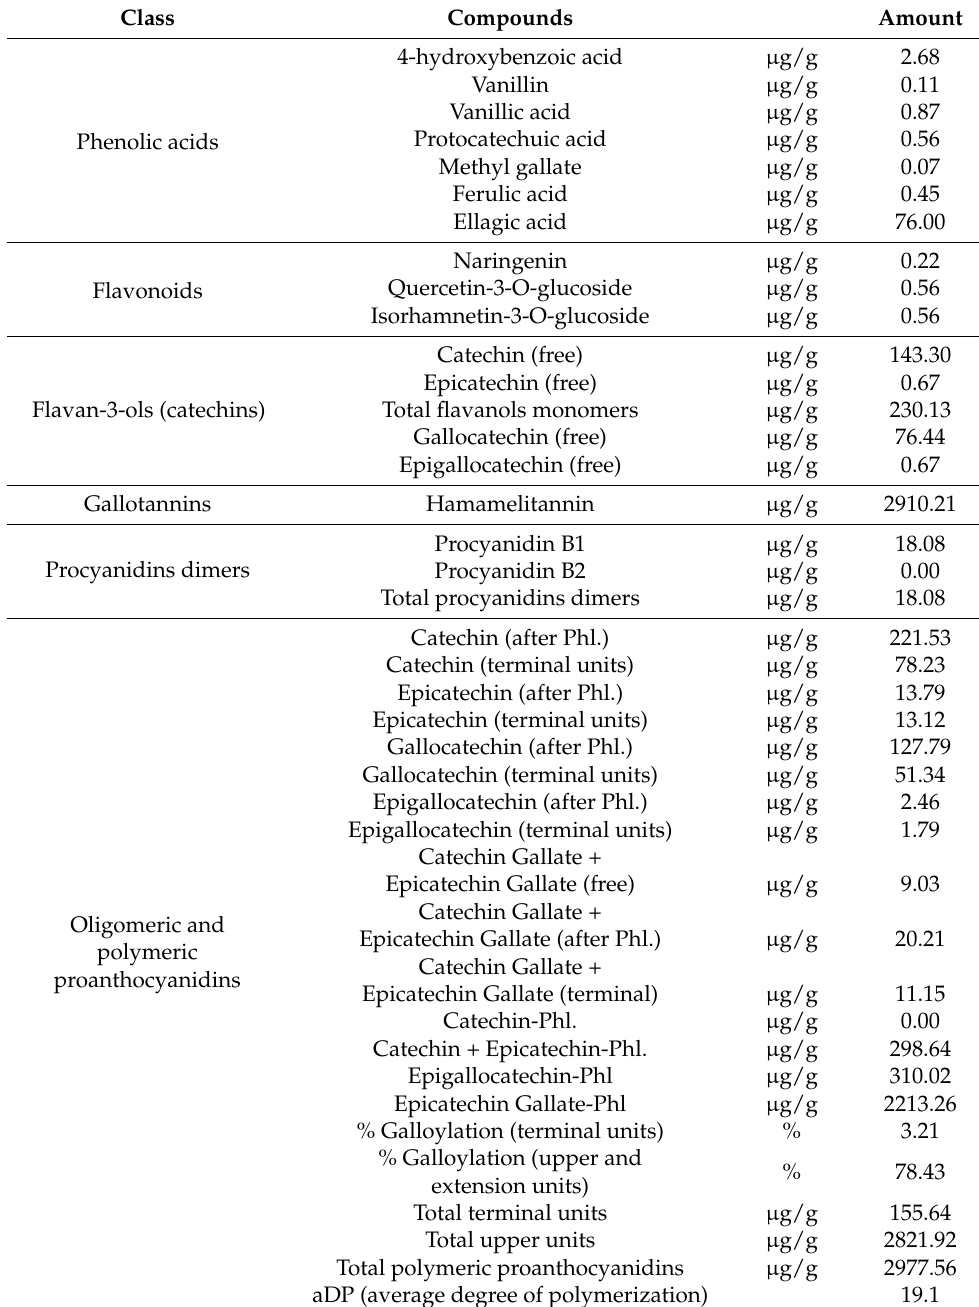
Table 1. Phytochemical composition of Hamamelis virginiana L. extract (HVE).